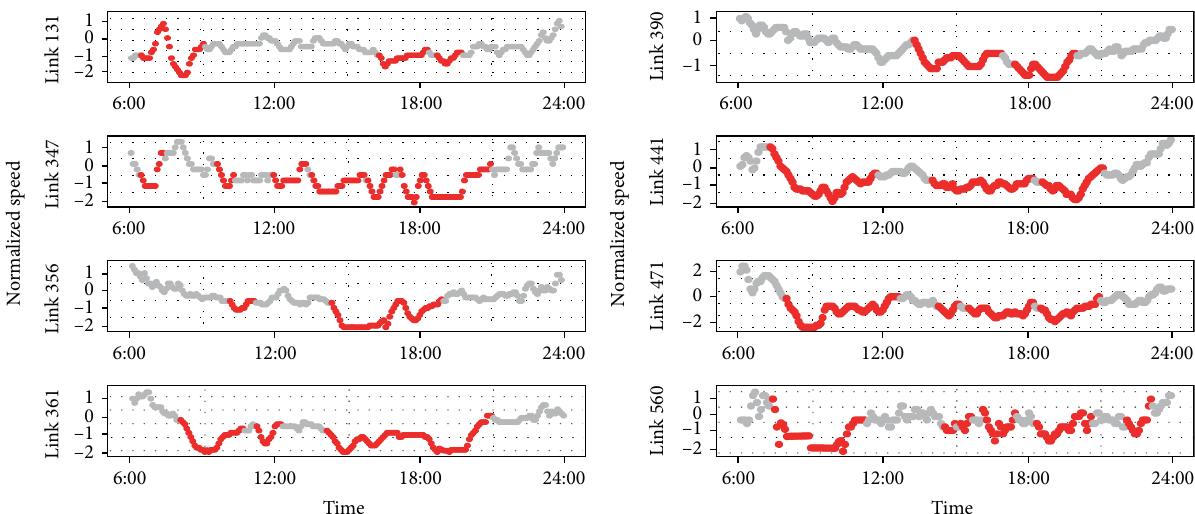
Figure 3: Traffic congestion on Friday identified by the valley searching-based algorithm.